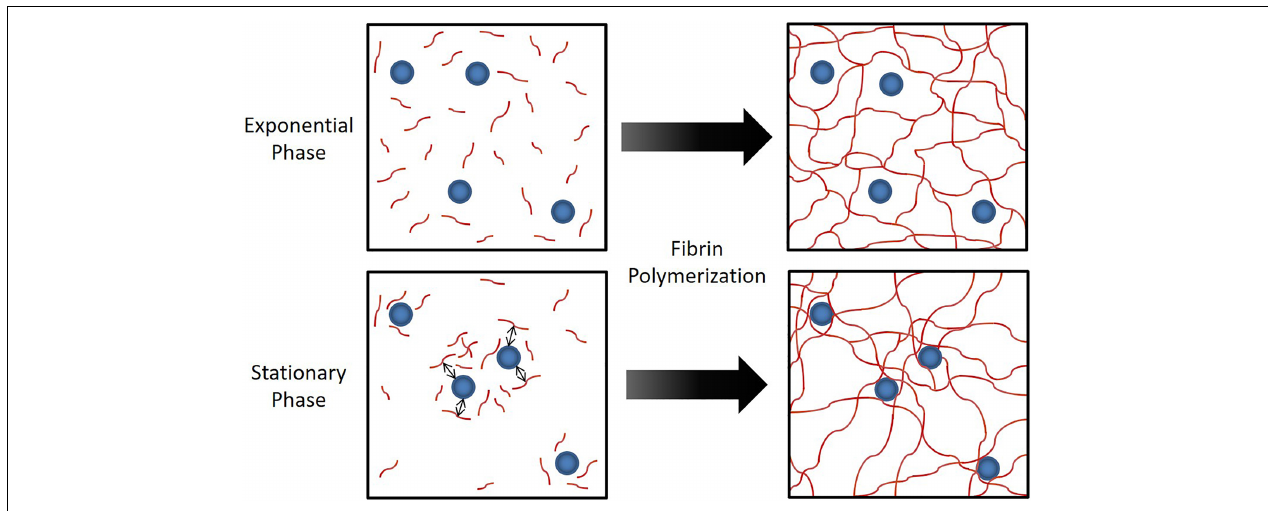
FIGURE 4 | Hypothesized mechanism for the observed phenomenon in Figure 3 . When S. epidermidis cells (blue circles) have sufficient affinity for fibrinogen (red lines), the attraction between cells and fibrinogen generate a heterogeneous fibrinogen distribution that results in a heterogeneous fibrin network structure. This has profound implications on fibrin network elasticity and ultimately potential for